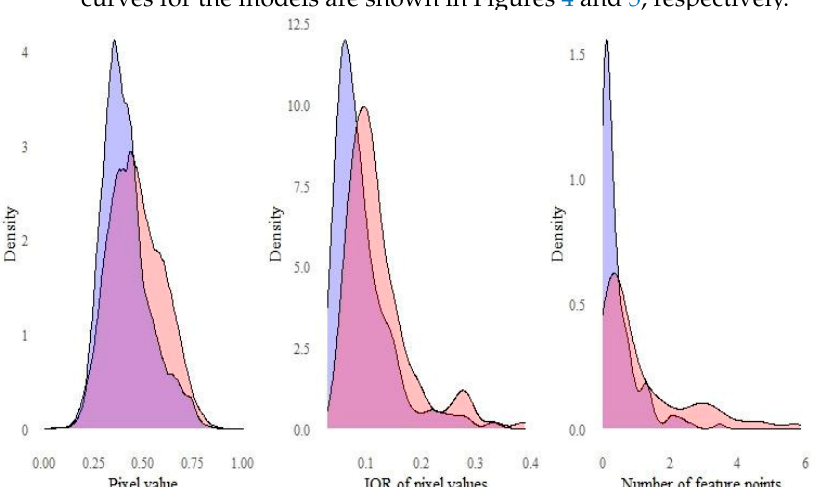
Figure 2. Kernel density curve for image features. Blue = non-dysphagic group, Red = sarcopenic dysphagic group.